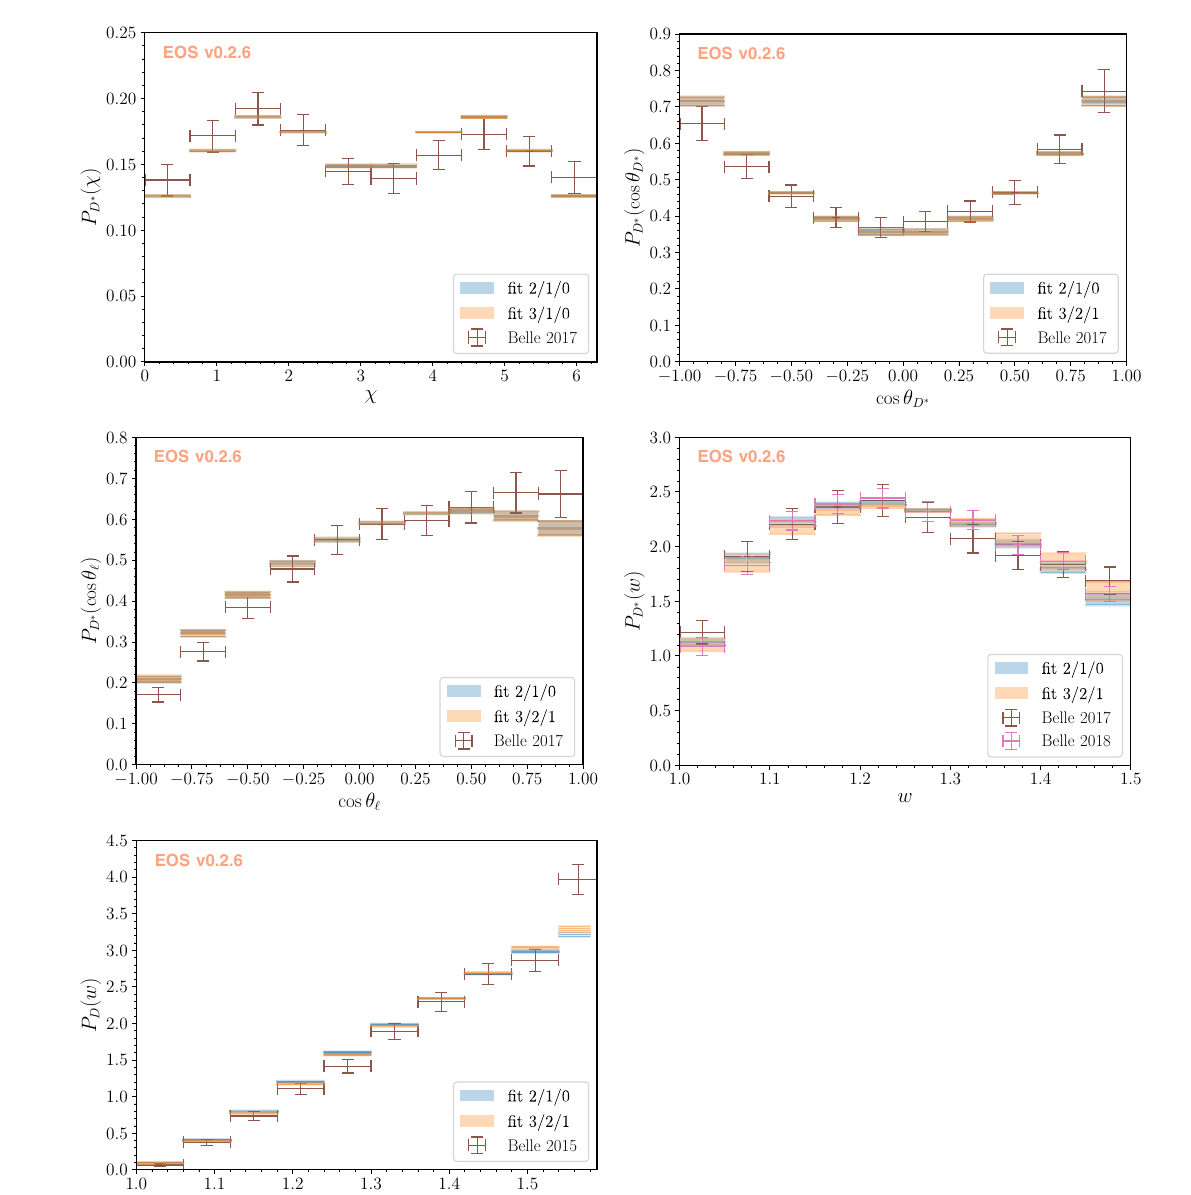
the 68% probability envelopes based on the two fit models fitted to only theory inputs. Note that for the 2018 Belle results we have unfolded the results ourselves; see the text for